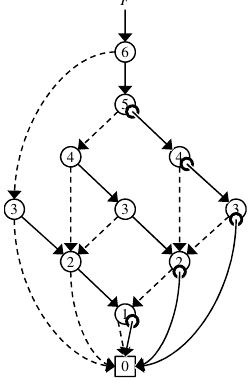
Figure 3. ZDD using 0-element edges that is equivalent to the ZDD in Figure